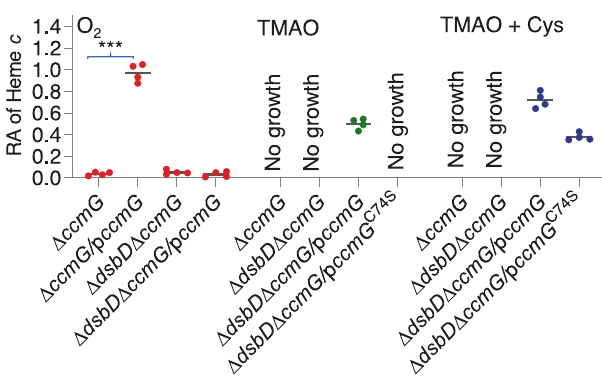
Fig. 6 Modulation of cyt c biosynthesis by NapB in the dsbD mutant depends on CcmG. Heme c levels in indicated strains grown to the early stationary phase. The relative abundance (RA) of heme c was obtained as described in Fig. 2b. TMAO + Cys, cultures supplemented with 5 mM Cysteine. Asterisks indicate statistically signi fi cant difference of the values compared ( n = 4; * P < 0.05; ** P < 0.01; *** P <